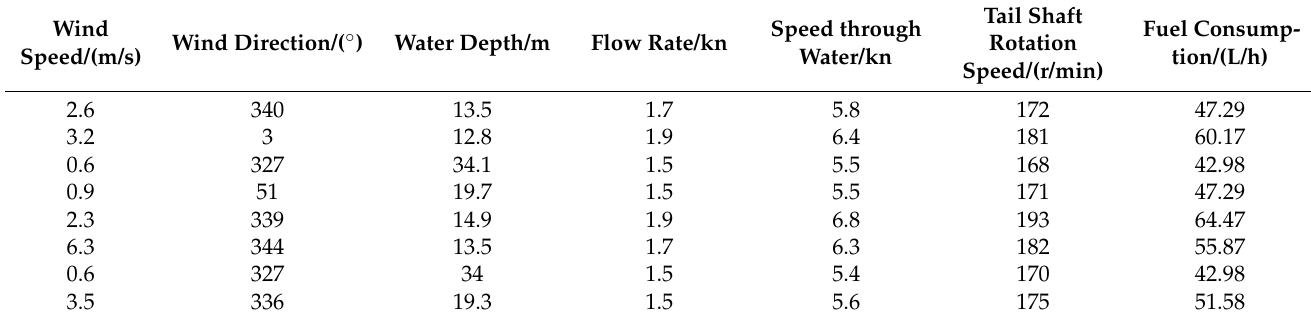
Table 2. Part of the verification data.